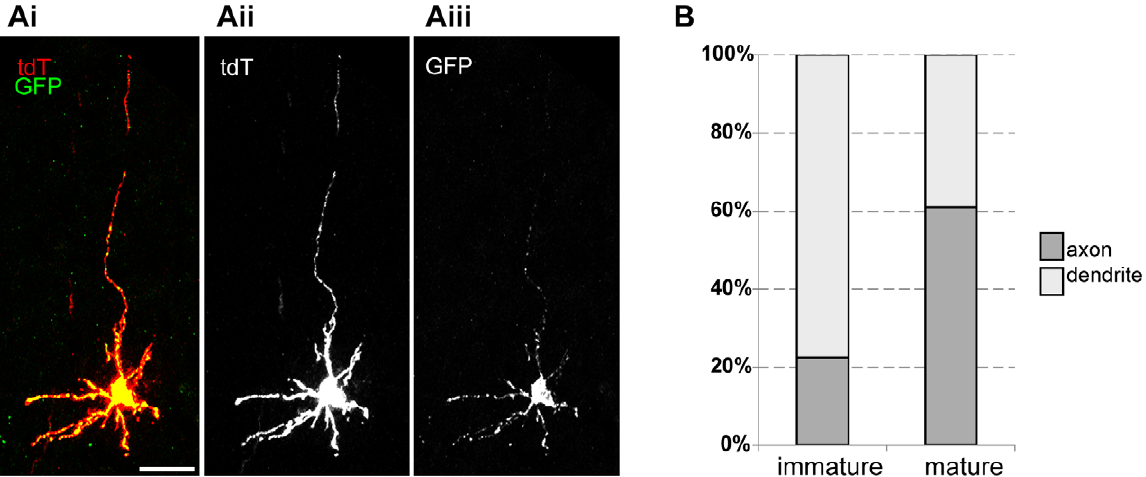
Figure 5. Syp-GFP distribution patterns in developing and mature GCs. (A) Representative confocal image of a labeled immature cerebellar GC from the mouse with the following genotype: ZtTA/wt; TRE-Bi-SG-T/wt; b -actin-CreER/wt, with tamoxifen administered at P7, and dissected at P15. In the merged panel Syp-GFP appears yellow, while tdT (red) fills the processes. (B) Quantification of Syp-GFP distribution in axonal and dendritic regions in mature and immature GCs showing that Syp-GFP becomes enriched in the axon after maturation. The graph shows an average for 10 cells for each condition. For mature cells, the standard deviation is 6 11%; for immature cells, the standard deviation is 6 7%. Two animals were used for analysis.